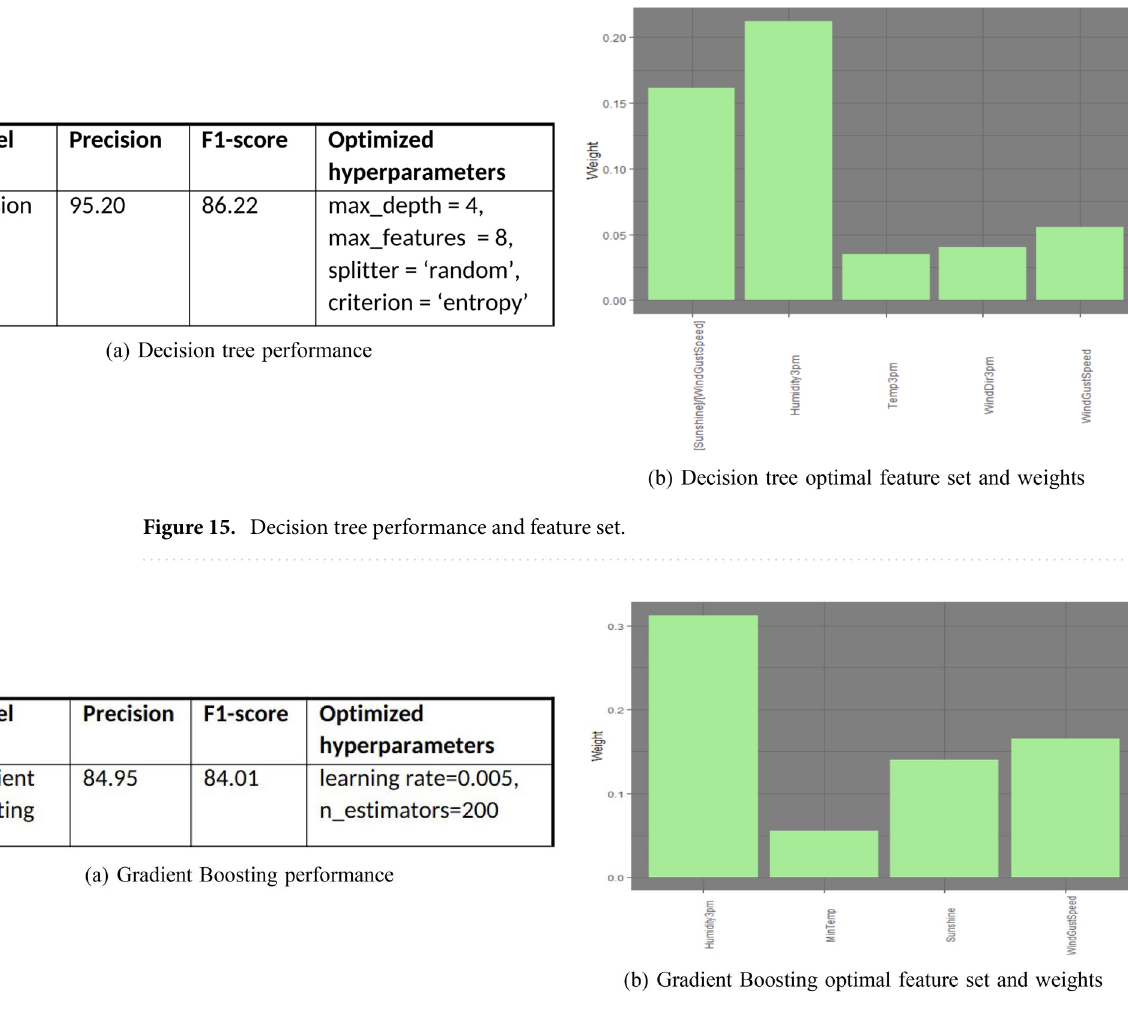
Figure 16. Gradient boosting performance and feature set.